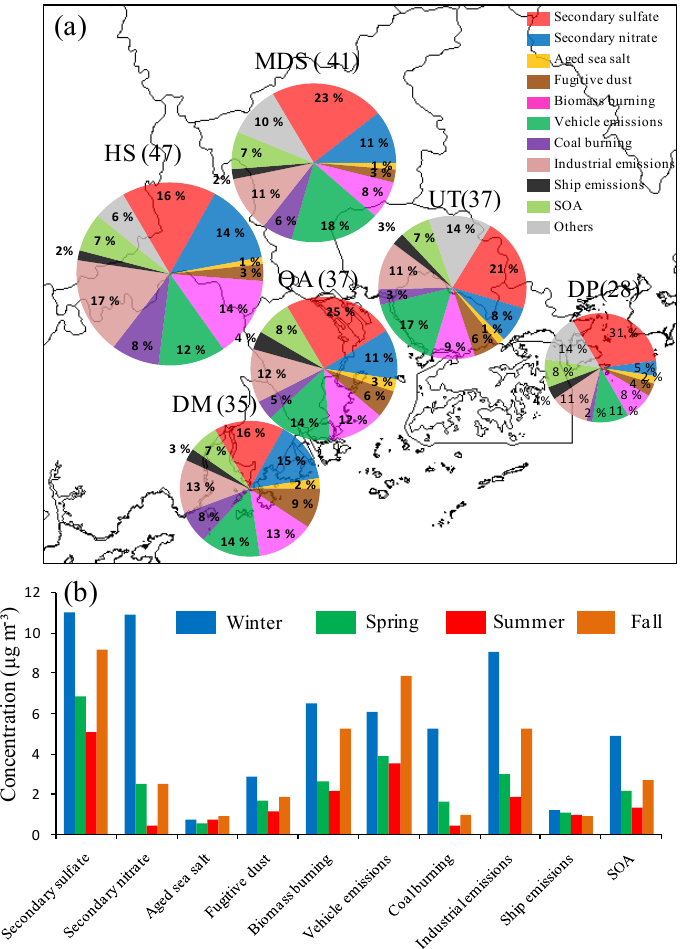
Figure 6. The spatial distributions of (a) and seasonal variations in (b) PM 2 . 5 sources in the PRD. Sizes of the pie charts indicate the concentrations of PM 2 . 5 at the six sites, with the detailed numbers (unit: µgm − 3 ) in